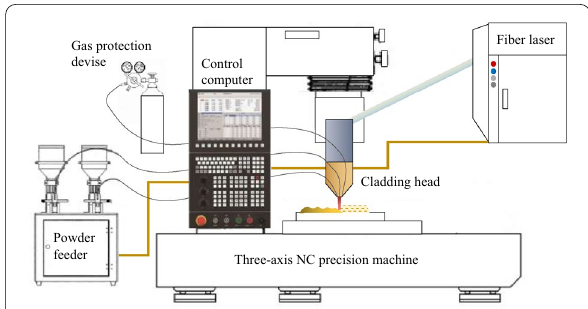
Figure 2 Schematic diagram of experiment apparatus for depositing